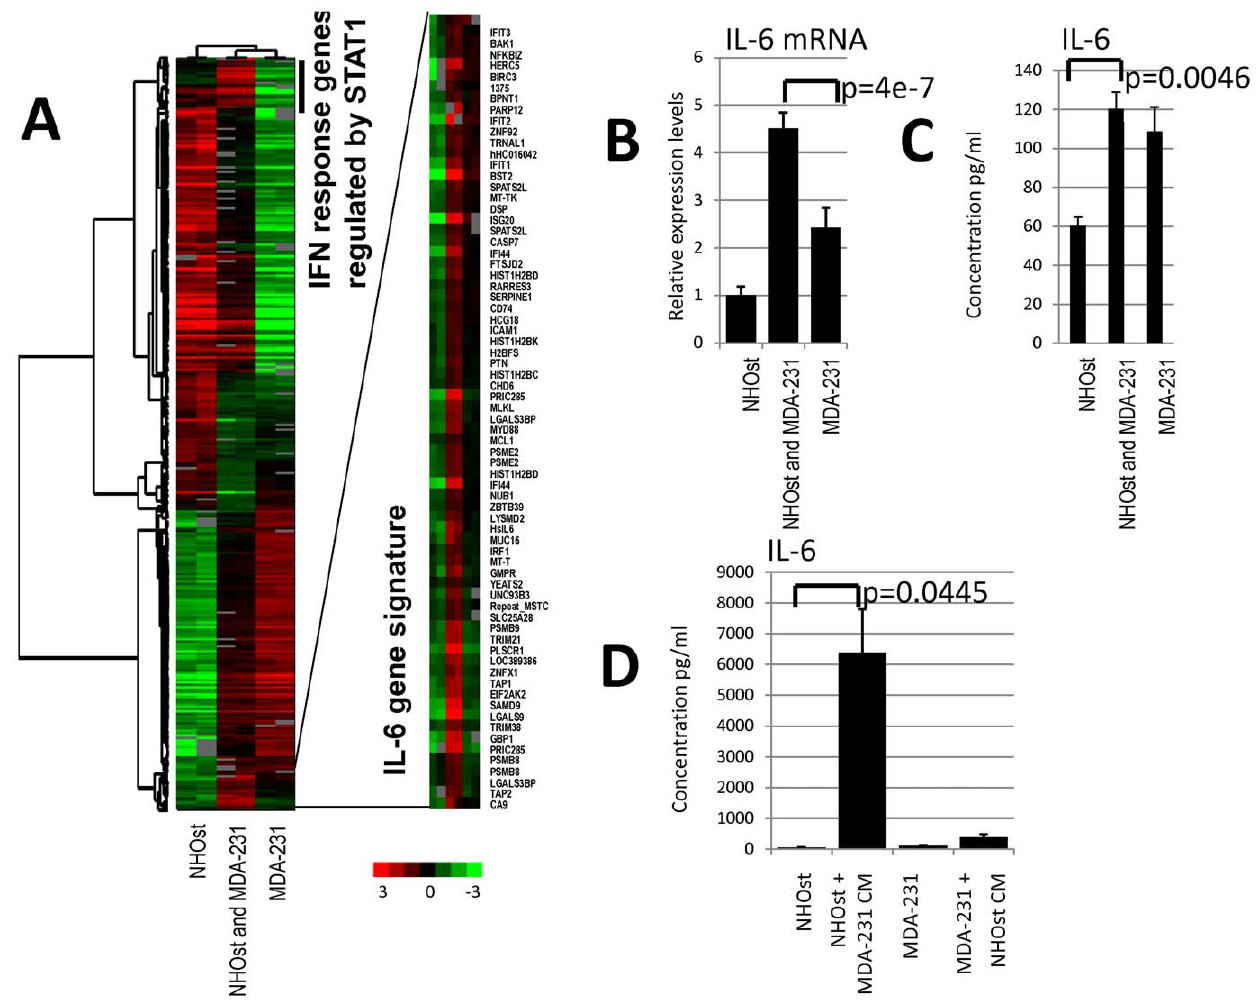
Figure 3. ‘‘Interferon response genes regulated by STAT1 signature’’ and ‘‘IL-6 gene signature’’ in co-culture. ( A ) Biologically independent replicates of the monocultured normal human osteoblasts (NHOst), the breast cancer cell line MDA-MB-231, and the mixed co-culture of NHOst and MDA-MB-231 cells were incubated for 48 hours under low serum conditions and characterized by DNA microarray hybridization. The figure shows the heat map of the hierarchical clustering of a total of 1461 elements that display a greater than 1.5-fold variance in expression of at least 2 different experimental samples. The co-culture of NHOst and MDA-MB231 induced two prominent sets of genes: An ‘‘interferon–response genes regulated by STAT1’’ signature and an ‘‘IL-6 gene signature’’ (zoomed image). ( B ) Real time PCR confirms a significantly higher expression of IL- 6 mRNA in the co-culture than in either of the two monocultures (p=4e-7; un-paired, two-tailed t -test). ( C ) As implied by the higher expression levels of IL-6 mRNA, the IL-6 concentration in the co-culture supernatants, as determined by ELISA, were significantly higher than the average concentration of the two monocultures. (p=0.0046; un-paired, two-tailed t -test). ( D ) Also IL-6 was significantly more highly induced in NHOst cells stimulated with conditioned medium from MDA-MB-231 cells than in MDA-MB-231 cells stimulated with conditioned medium from NHOst (p=0.045; un-paired,